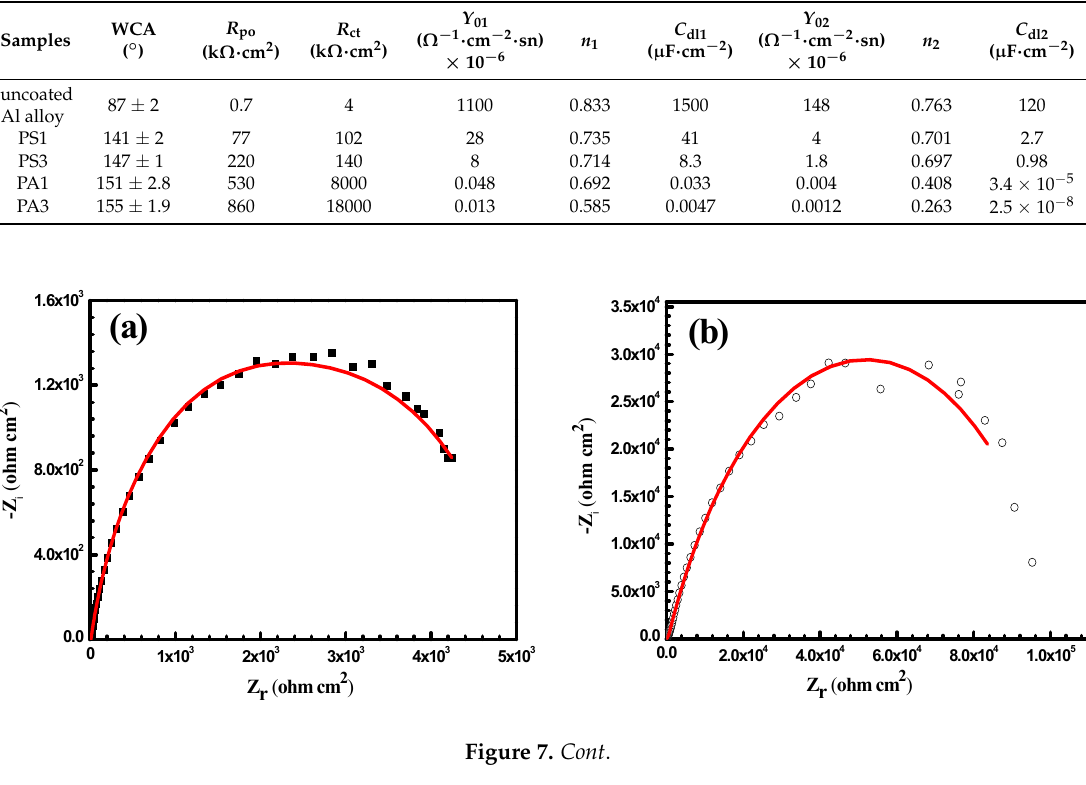
Table 5. The electrochemical parameters from Nyquist and Bode plots for the uncoated and coated aluminum substrates with pure electrospun PS (PS1 & PS3), and nanocomposite SHCs of polystyrene and aluminum oxide (PA1 & PA3), in 3.5 wt % NaCl solution.